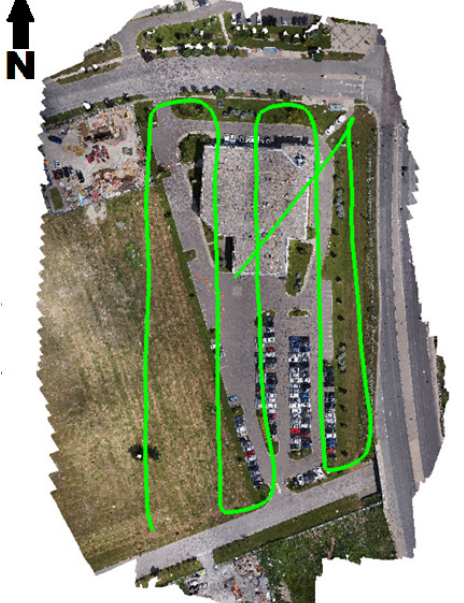
Figure 1. Point cloud generated from aerial imagery collected by the Geo-X8000 UAV. The green line indicates the flight path of the Geo-X8000.